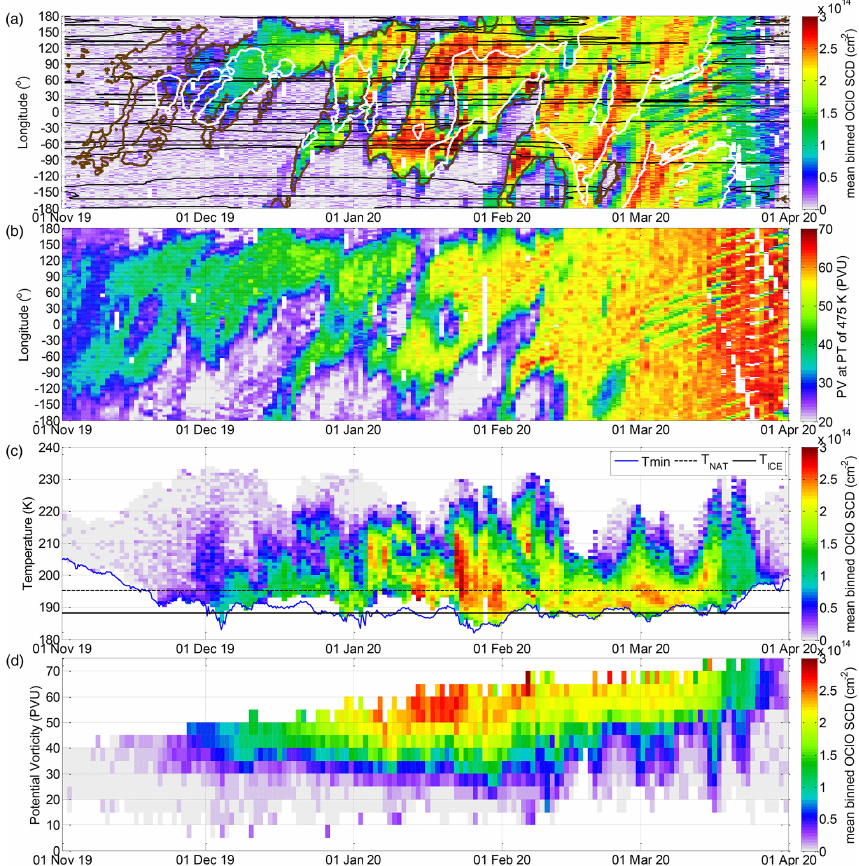
Figure A3. Same as Fig. 8 but with the assumed measurement location coordinate shifted by 100km from the line-of-sight coordinate towards the